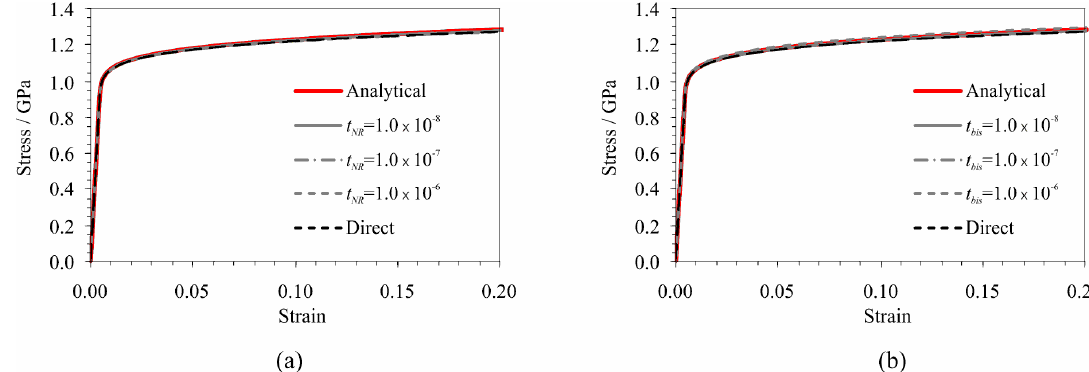
Figure 7. Stress-strain relation in the triangle obtained by: ( a ) Newton–Raphson; and ( b ) bisection iterative procedure for evaluation of plastic correction parameter Γ .